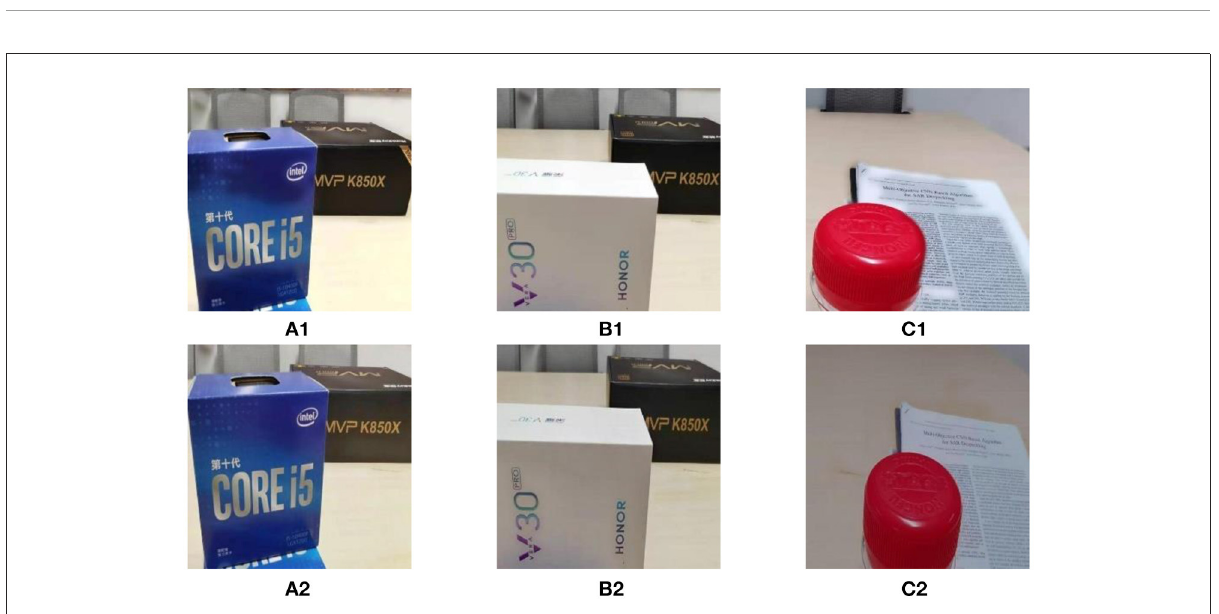
FIGURE4 The fusion results before and after standardization of the image basic attribute. (A1–C1) are the fused images for the multi focus image pair without image basic attribute standardization processing. (A2–C2) are the fused images by image basic attribute standardization processing.